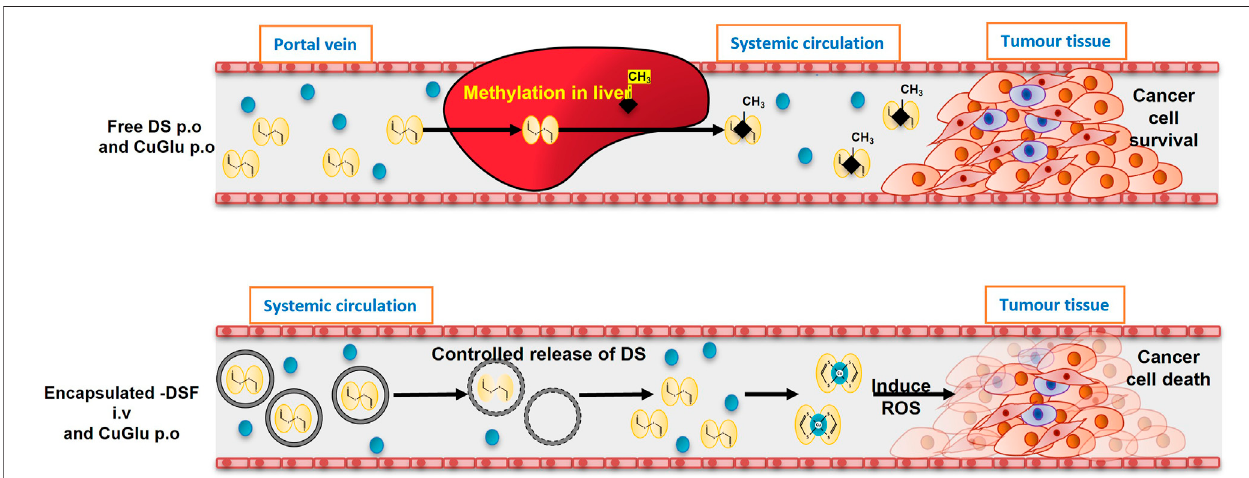
FIGURE4| ThemodelsoforalandintravenousadministrationofDS.A.Afteroraladministration,DSwillbedelivered via portalveinandenrichedinliverinwhichitis instantly methylated. The methylated DS inhibits ALDH and remains its antialcoholism function. Because the thiol group is blocked, its anticancer activity is completely abolished. B. In the new intravenous formulation of DS, the thiol groups in DS are protected. After delivered to cancer tissues, DS chelates copper to generate ROS inducing apoptosis. The end product, DDC-Cu, can penetrate into cancer cells and trigger apoptosis, as well (Tawari et al. Toxicol Res 2015; 4:1439). This hypothesis explained the discrepancy of anticancer activity of DS in the lab and in clinic and the need to develop intravenously applicable nano-encapsulated DS, e.g. liposome and PLGA encapsulated DS.